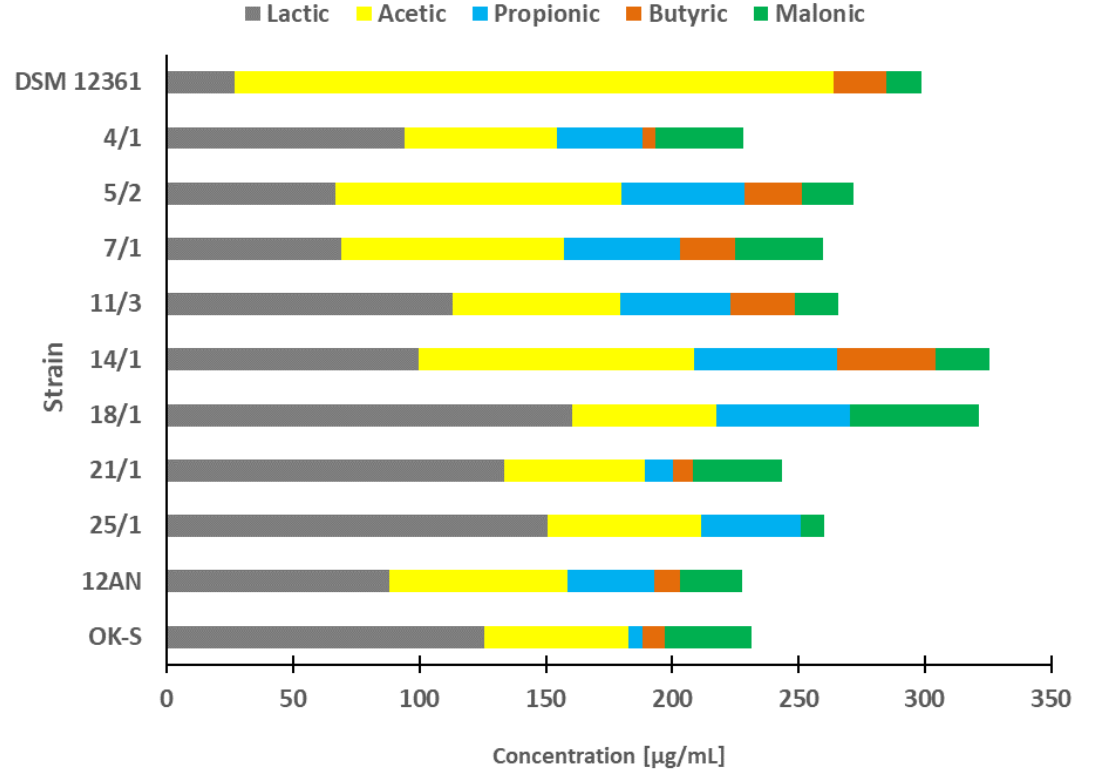
Figure 1. Organic acids profiles in cell-free supernatants from lactic acid bacteria after 24 h cultivation in MRS medium.